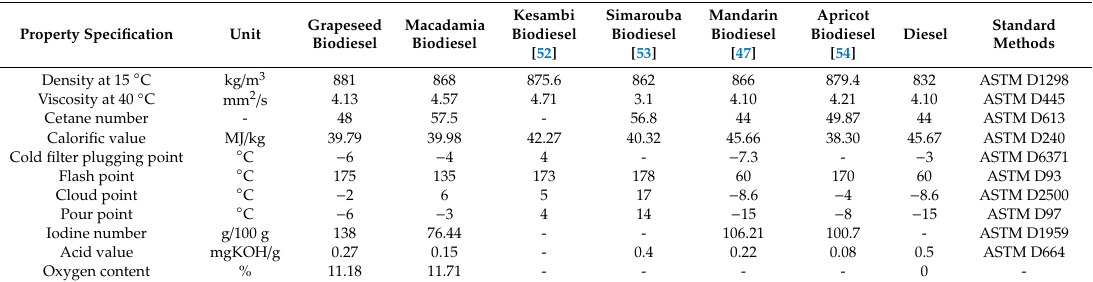
Table 2. Physicochemical fuel properties of the biodiesels.